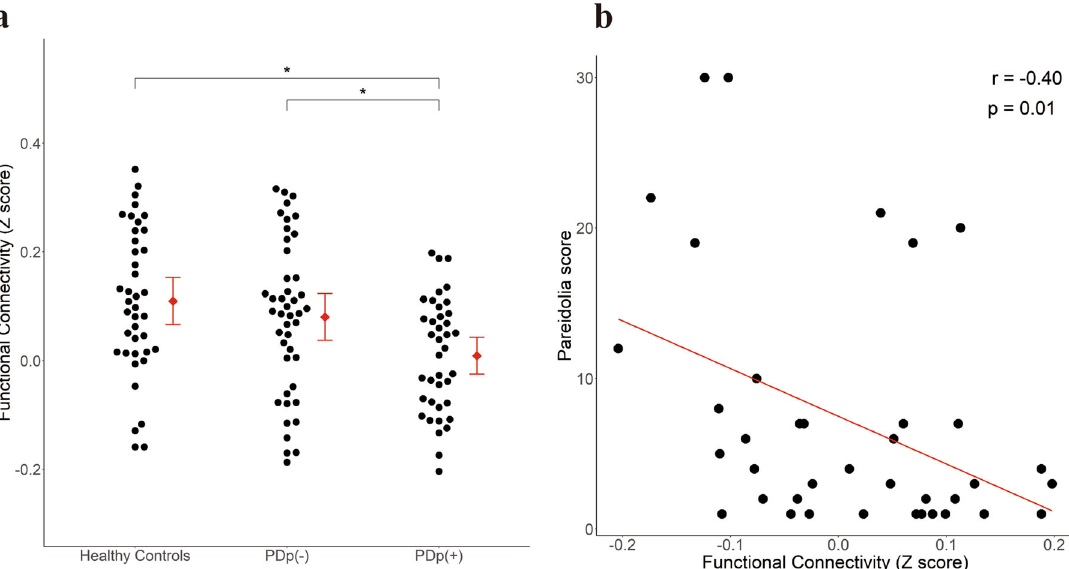
Fig. 3 Groupwise comparison of front-temporal networks and its correlation with the pareidolia score. FC shows Z -scores of the correlation coef fi cient between the medial frontal cortex and the bilateral fusiform cortices. a (left): Dot-plot shows comparison of FC among the three groups. The mean of each group with 95% con fi dence intervals are shown as red rhombi with error bar. * FDR-p < 0.05. (ANOVA with FDR adjusted post hoc Tukey – Kramer test). b (right): Correlation between frontotemporal connectivity and pareidolia score. Scatter plot shows Pearson ’ s correlation between FC and pareidolia scores in patients with pareidolia. FC functional connectivity, ANOVA analysis of variance, FDR false discovery